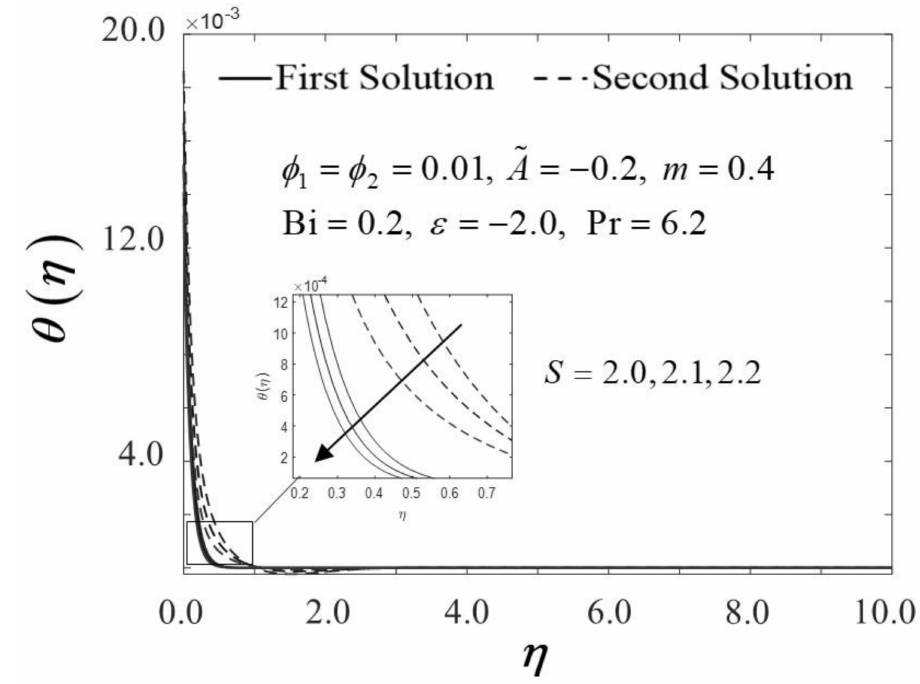
Figure 13. Trend of θ ( η ) with η and assorted S .